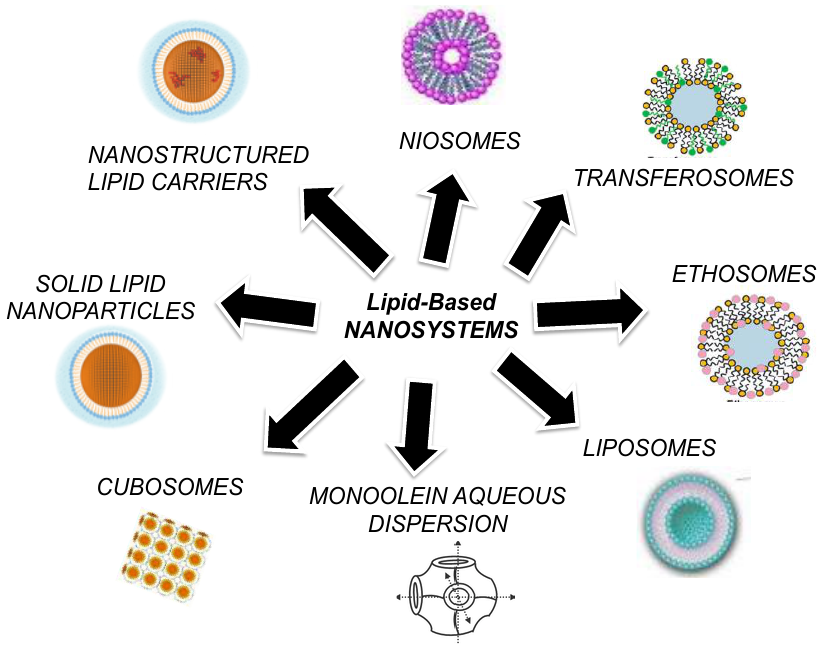
Figure 1. Schematic representation of LBNs considered in this review.